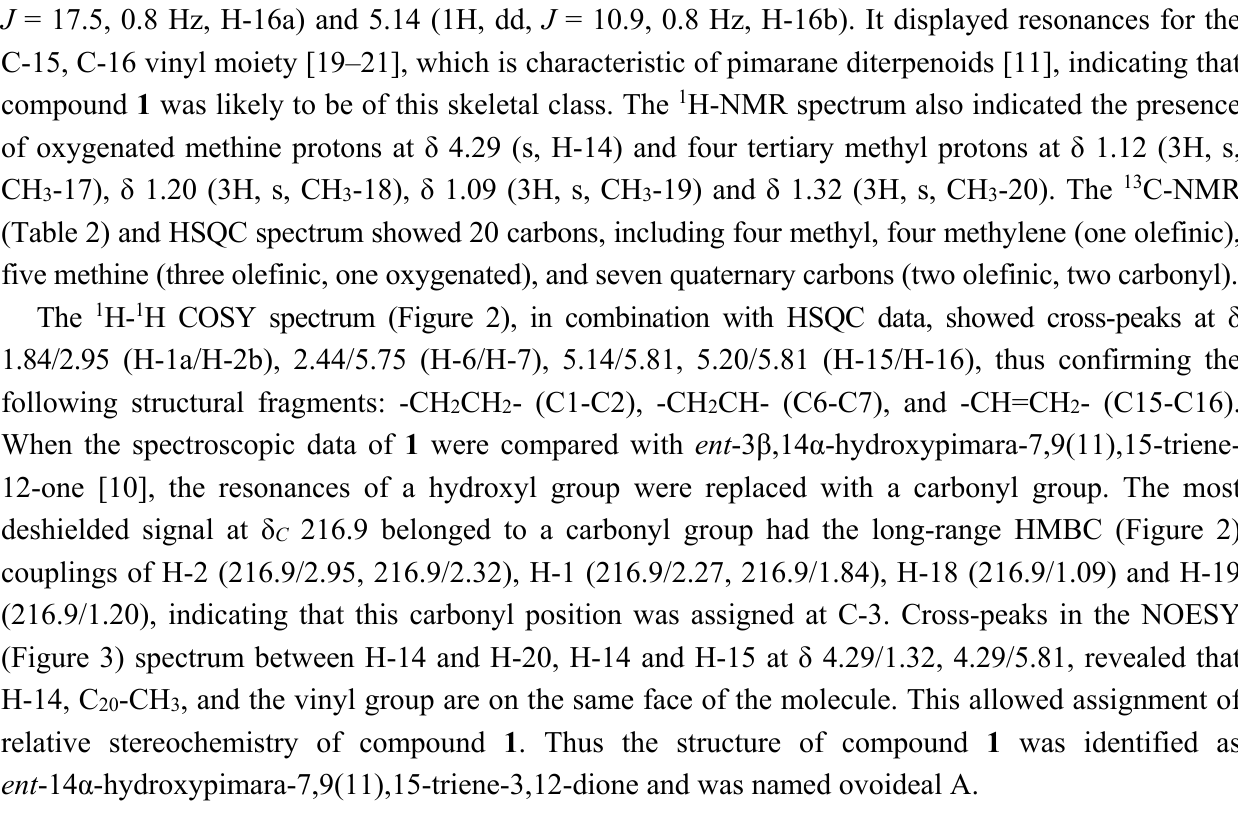
Figure 3. Main NOESY correlations of compounds 1 – 7